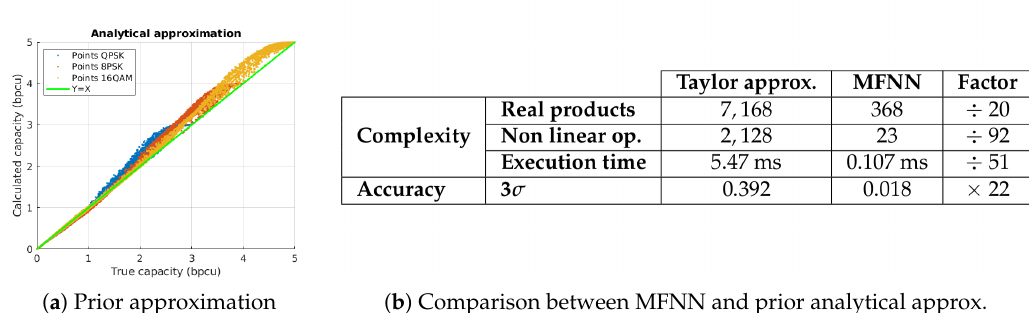
Figure 2. Performance comparison of the previous analytical approximations and the MFNN for obtaining the contrained capacity of SM with three constellations (QPSK, 8PSK and